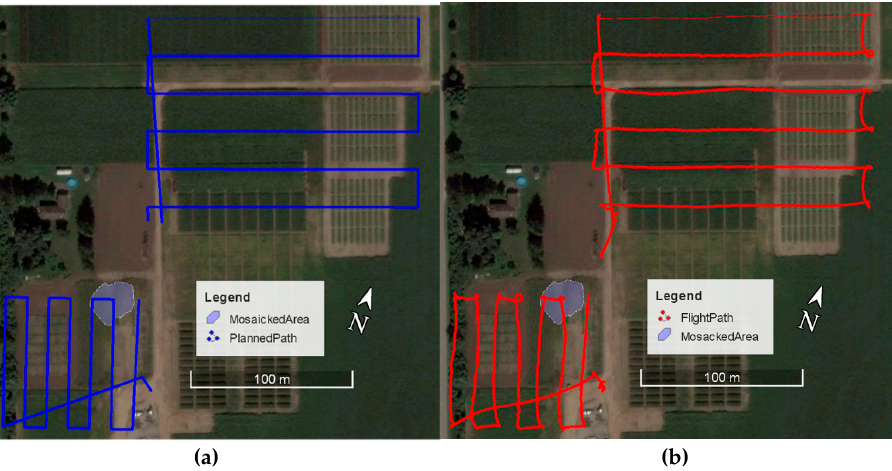
Figure 3. The study site with the planned flight path ( a ), and the actual flight path ( b ) draped over a Google Earth image, taken on a later date (3 September 2016). (Site 1 at bottom left: tomato field; Site 2 in upper right: corn and soybean fields).